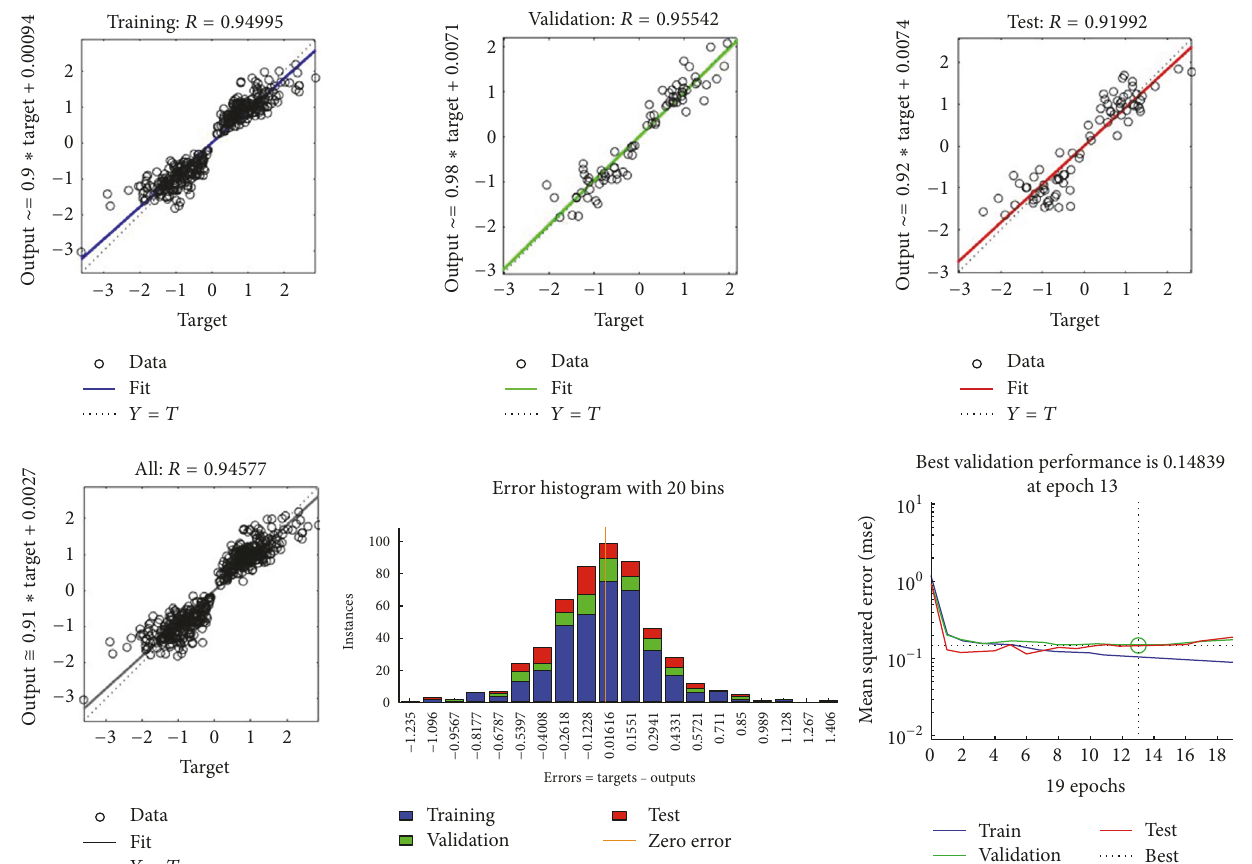
Figure 12: Regression plot, histograms error, and mean square error for column ductility from LMA in group 5 (Approach